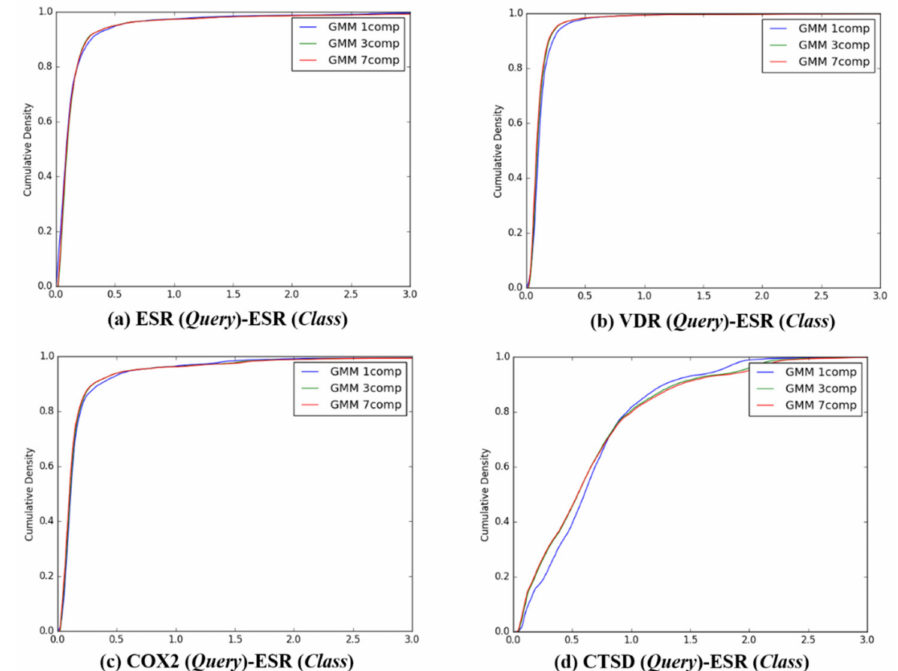
Figure 4. The cumulative densities of K–L distance between Q -distribution (Target class: ESR) and queries. X -axis: K–L divergence, Y -axis: cumulative density; Q -distribution of ESR through GMM and the distribution of queries were calculated. ( a ) ESR(Query)-ESR(Class), ( b ) VDR(Query)-ESR(Class),